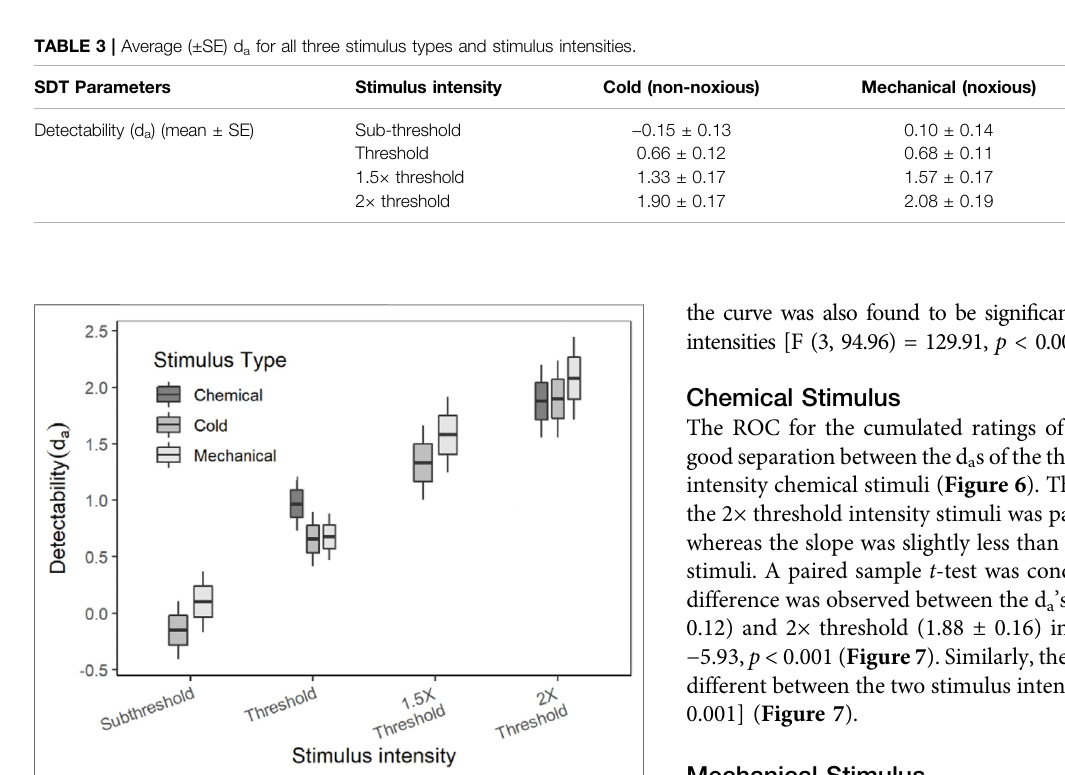
Frontiers in Pharmacology |